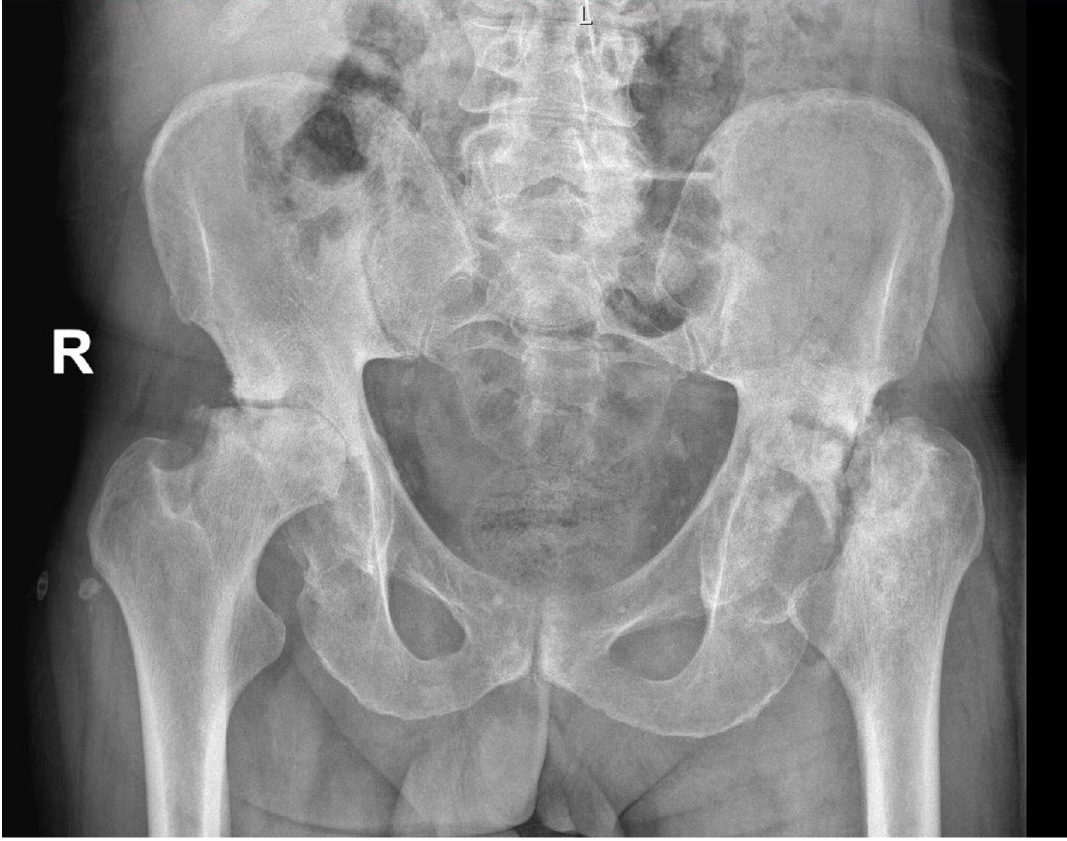
Figure 1. Radiological image of bilateral avascular osteonecrosis in a patient with diabetes mellitus with no other comorbidities. R—right.